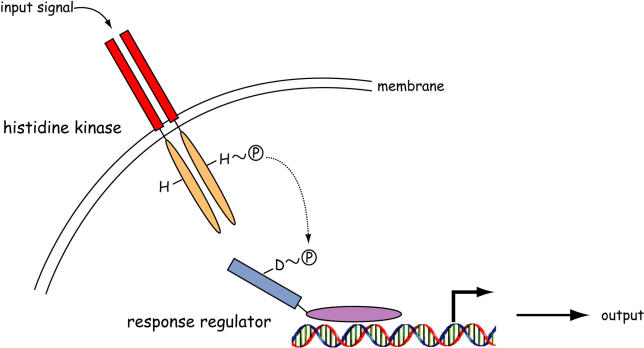
In the two-component signaling pathway, a stimulus causes a histidine kinase to autophosphorylate on a conserved histidine (H) residue. The phosphoryl group (P) is then transferred to a conserved aspartate (D) residue of a cognate response regulator; when the response regular phosphorylates, it triggers a physiological response, such as gene transcription